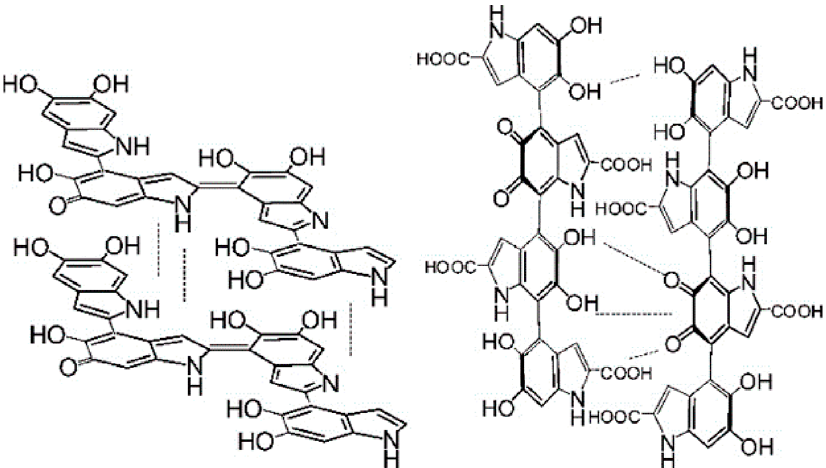
Figure 4. Representative structures of DHI and DHICA melanin. Left: DHI, right: DHICA. Adapted from [75] with minor modifications.